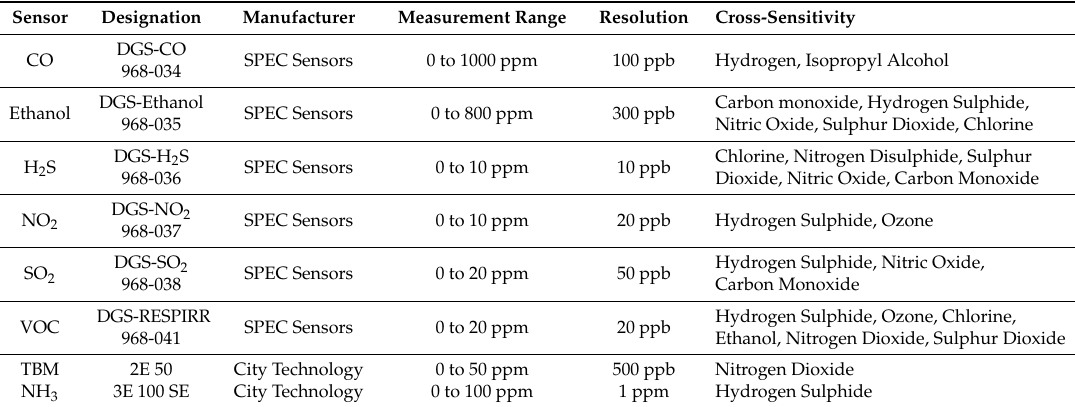
Table 1. Sensors used in the prototype electronic nose.